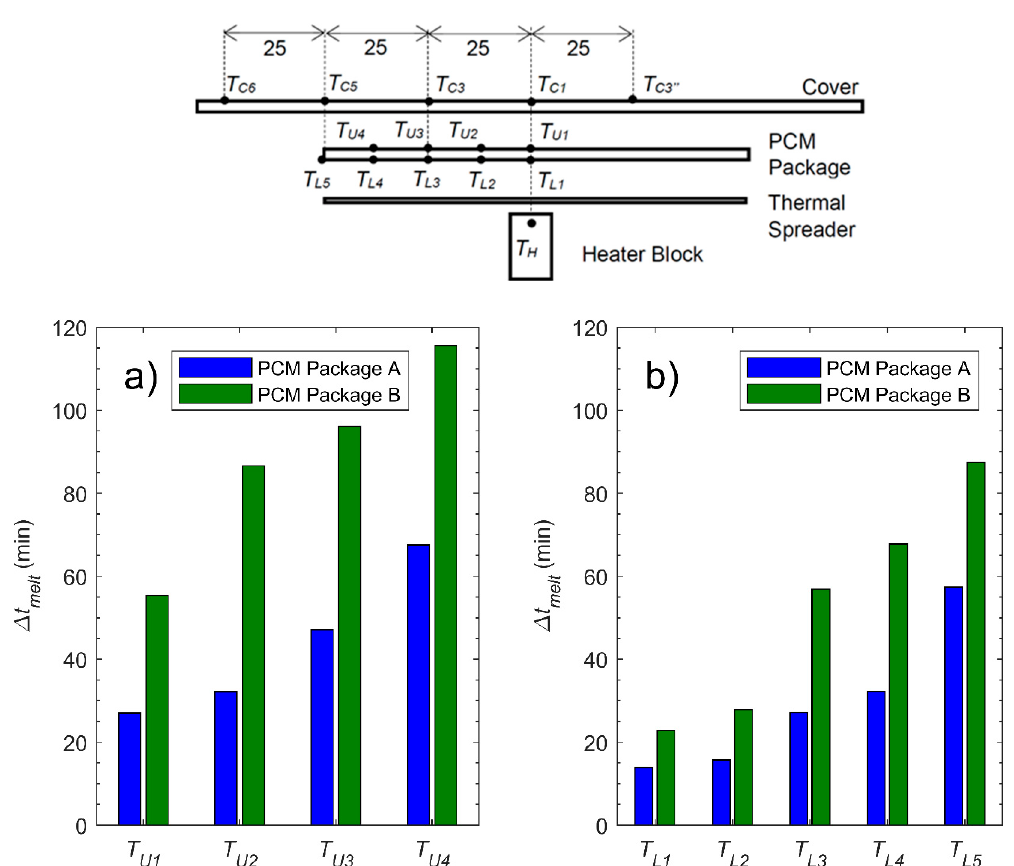
Figure 10. Time intervals ( ∆ t mel t ) for the thermocouple mounted ( a ) at the upper surface and ( b ) at the lower surface of both PCM packages to reach their respective PCM melting temperature for the experiment with the thermal spreader and a constant power input of 5 W for 120 min.